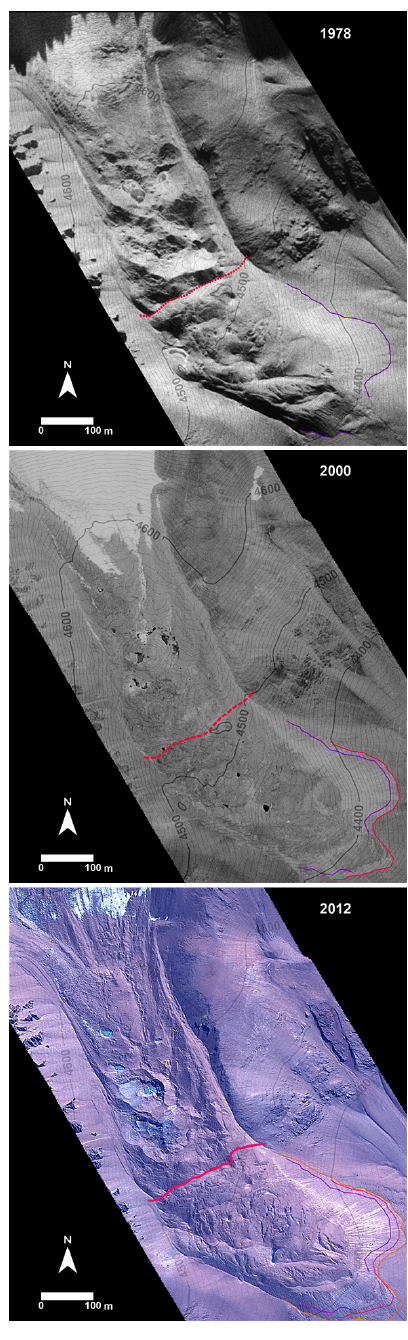
Figure 8. Sequence of orthophotos obtained for Las Tetas. The base of the landform front that could be reliably identified is indicated in colour (blue, magenta, and orange line in 1978, 2000, and 2012, respectively). At each date the boundary between debris-covered and rock glacier morphology is depicted with a red line (dotted in 1978, dashed in 2000, and continuous in